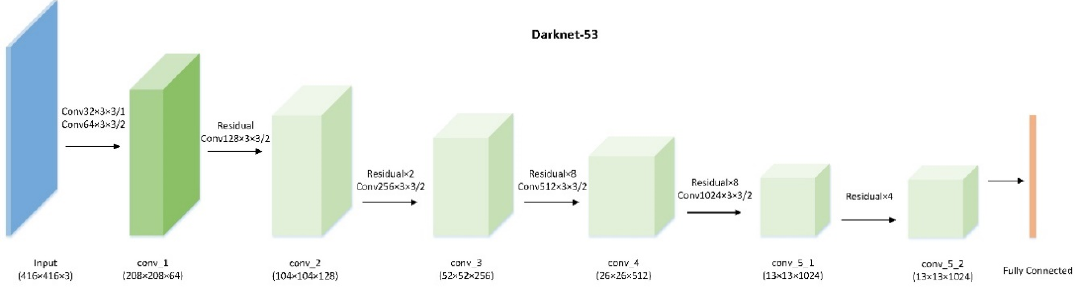
Figure 3. Darknet-53: the base network to extract features in the single-shot object detection framework.